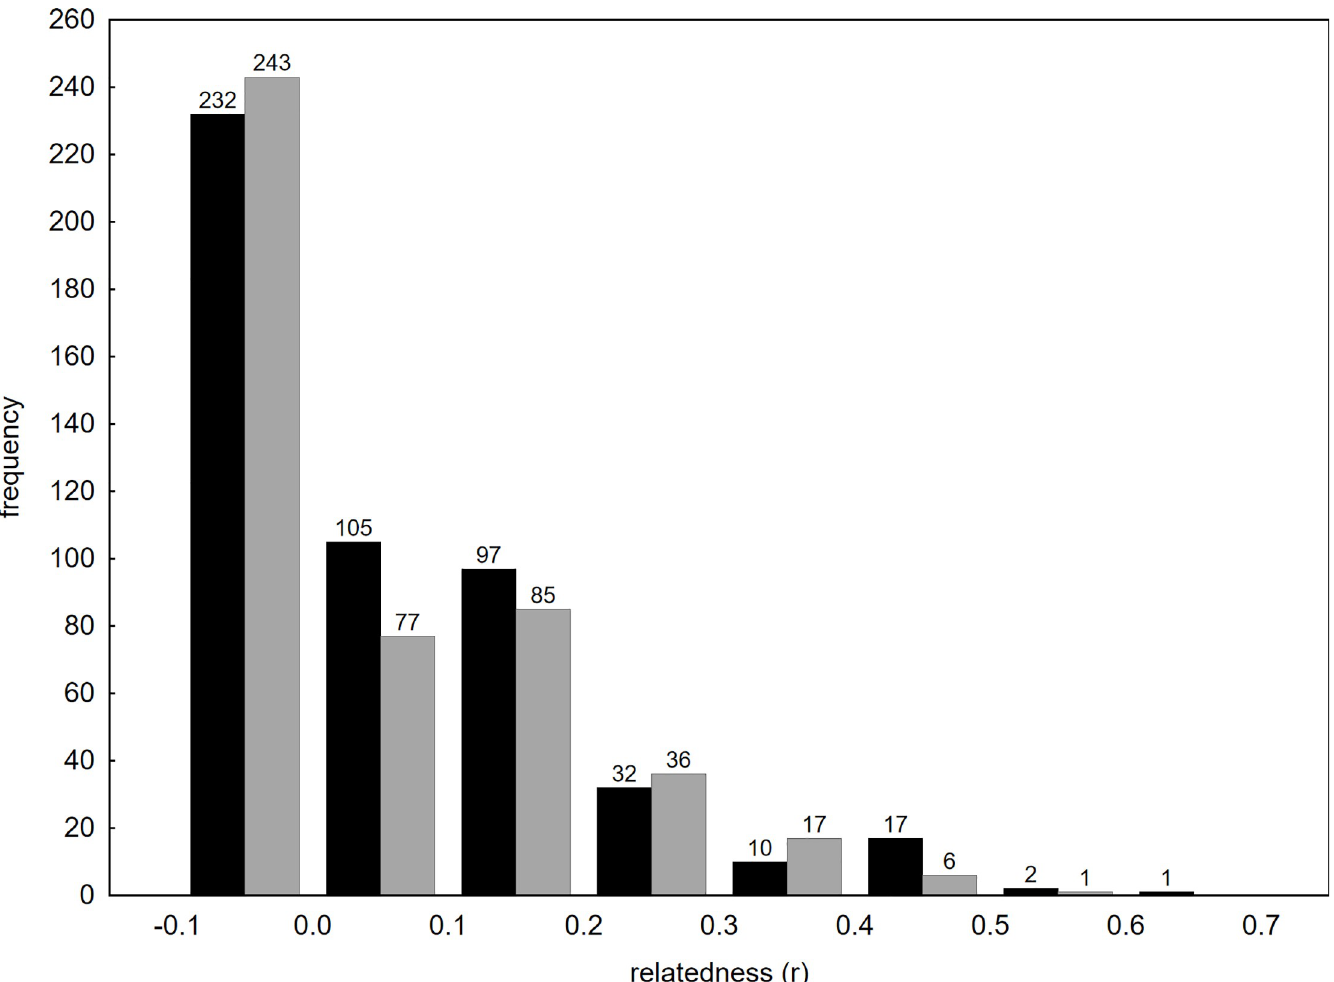
Fig 2. Distribution of pair-wise relatedness coefficients. Black columns represent winter, grey columns spring, the number above the columns is the count of observed values.